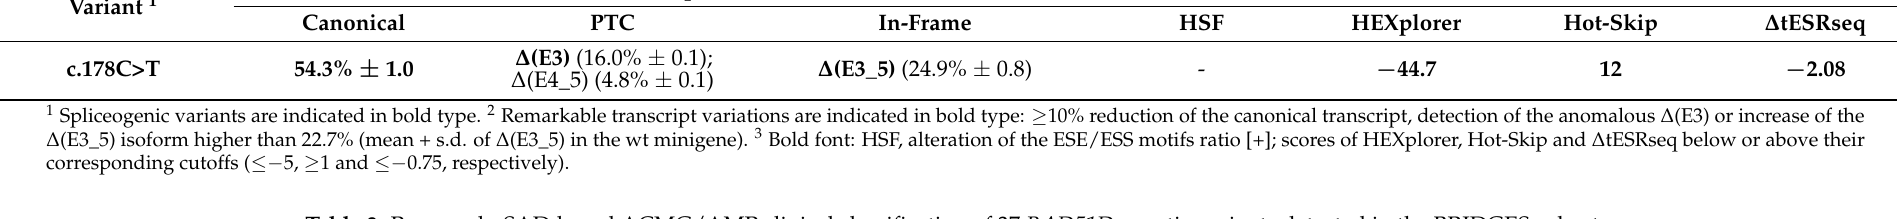
Table 3. Proposed pSAD-based ACMG/AMP clinical classification of 37 RAD51D genetic variants detected in the BRIDGES